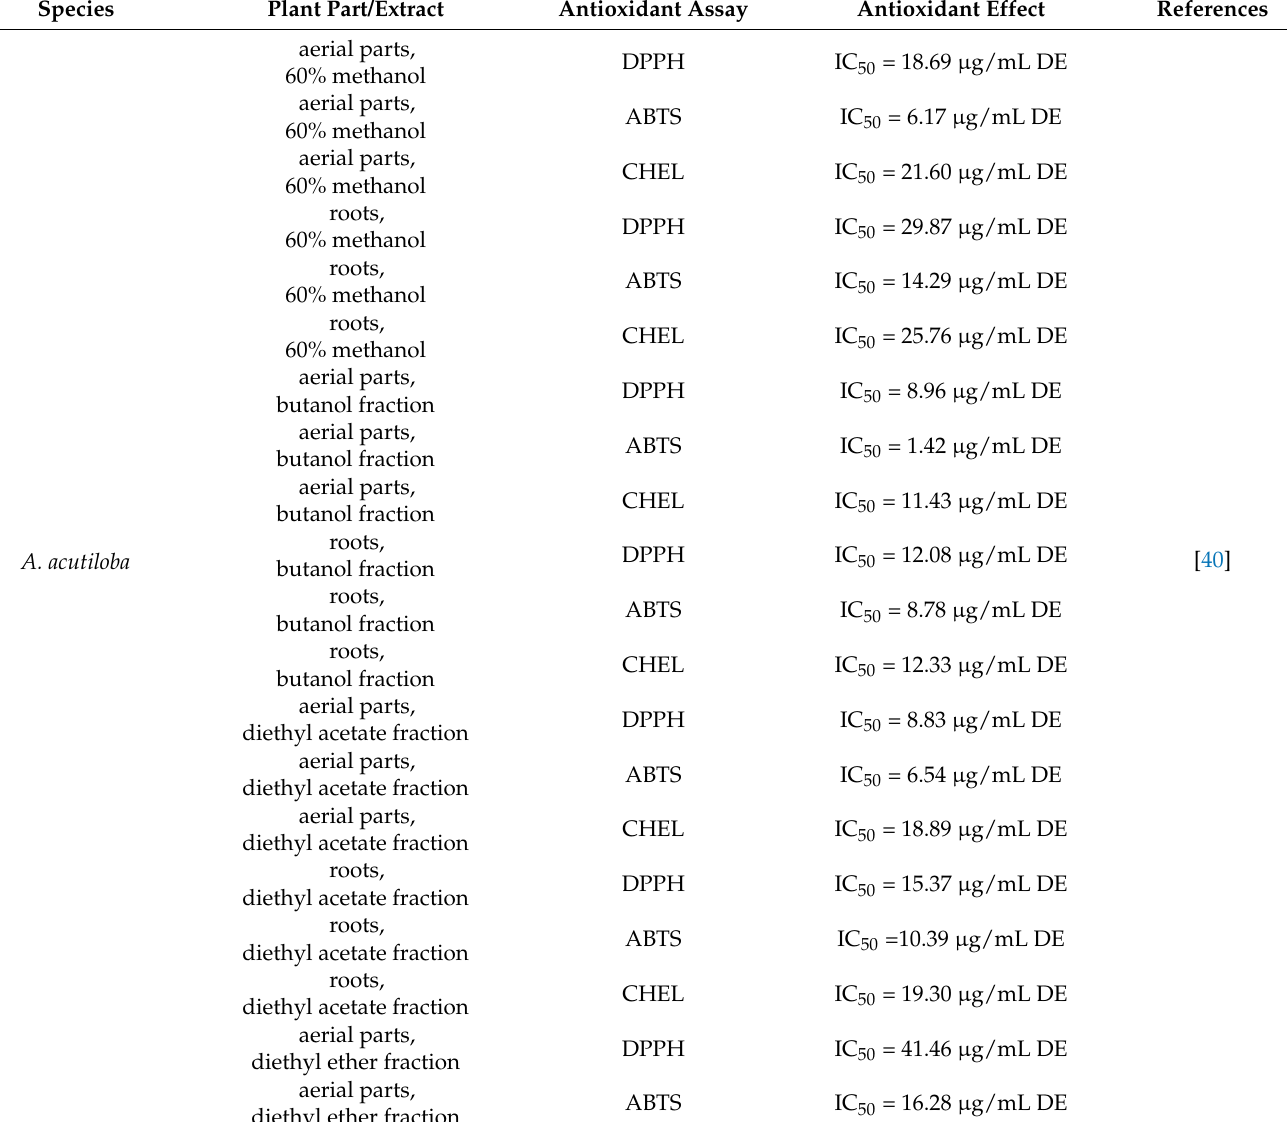
Table 10. The overview on the antioxidant activities in Alchemilla species. Species Plant Part/Extract Antioxidant Assay Antioxidant